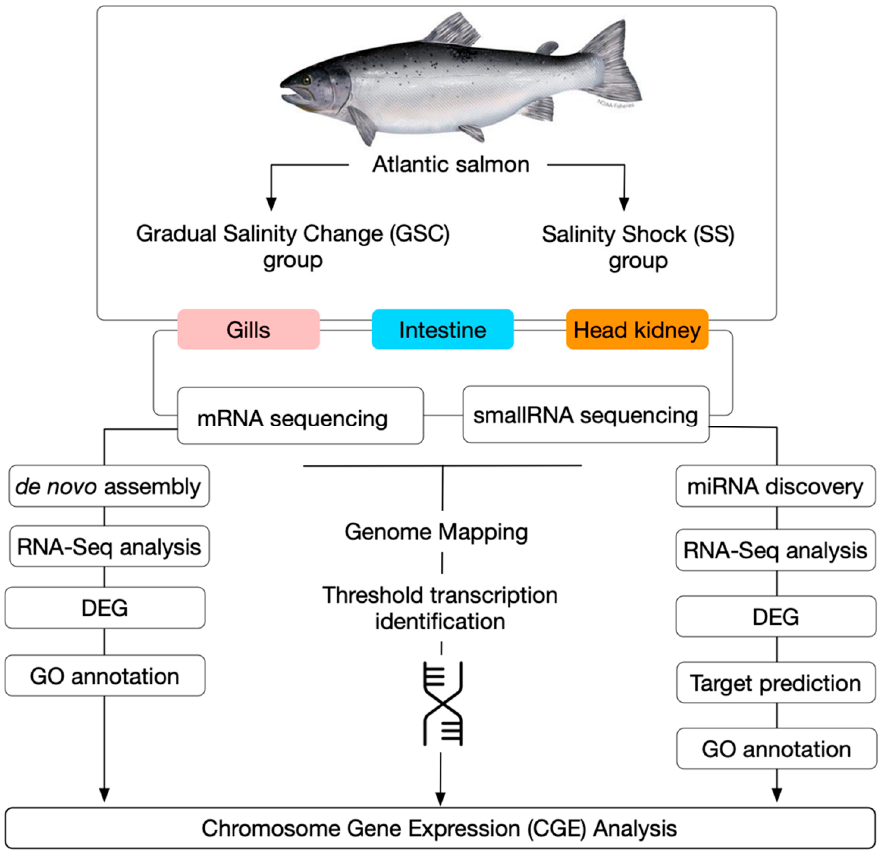
Figure 1. Whole-genome expression approach for transcriptome analysis during smoltification in Atlantic salmon.